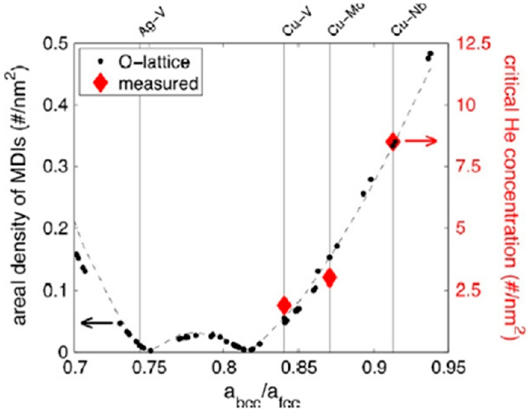
Figure 22. The excellent agreement between the densities of misfit dislocation intersection at interfaces and the critical He concentrations at interfaces for a number of fcc/bcc NMMFs. Red diamonds are measured values of the critical He concentrations [135].